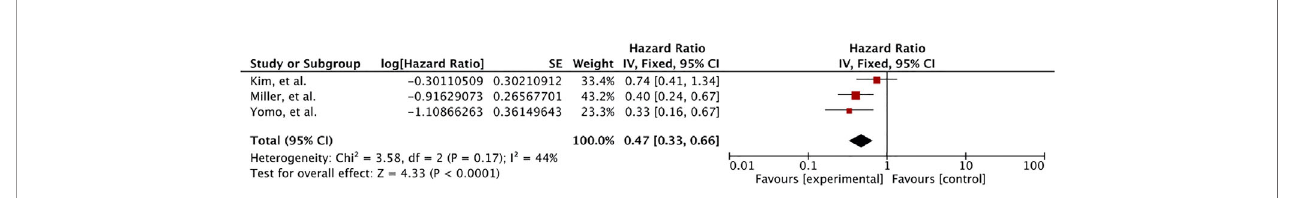
FIGURE 3 | Forest plot of meta-analysis of local control (LC) for treatment comparison (Lapatinib plus SRS versus SRS alone) in the management of brain metastases from HER-2 positive breast